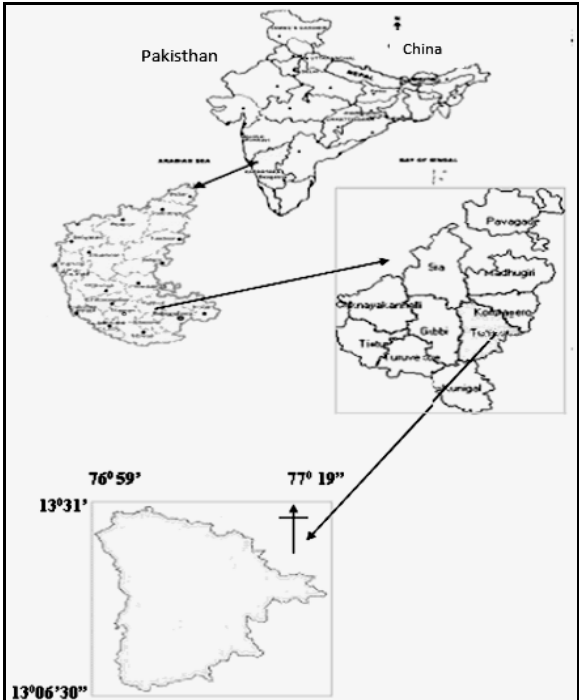
Figure 1 . Location map of the study